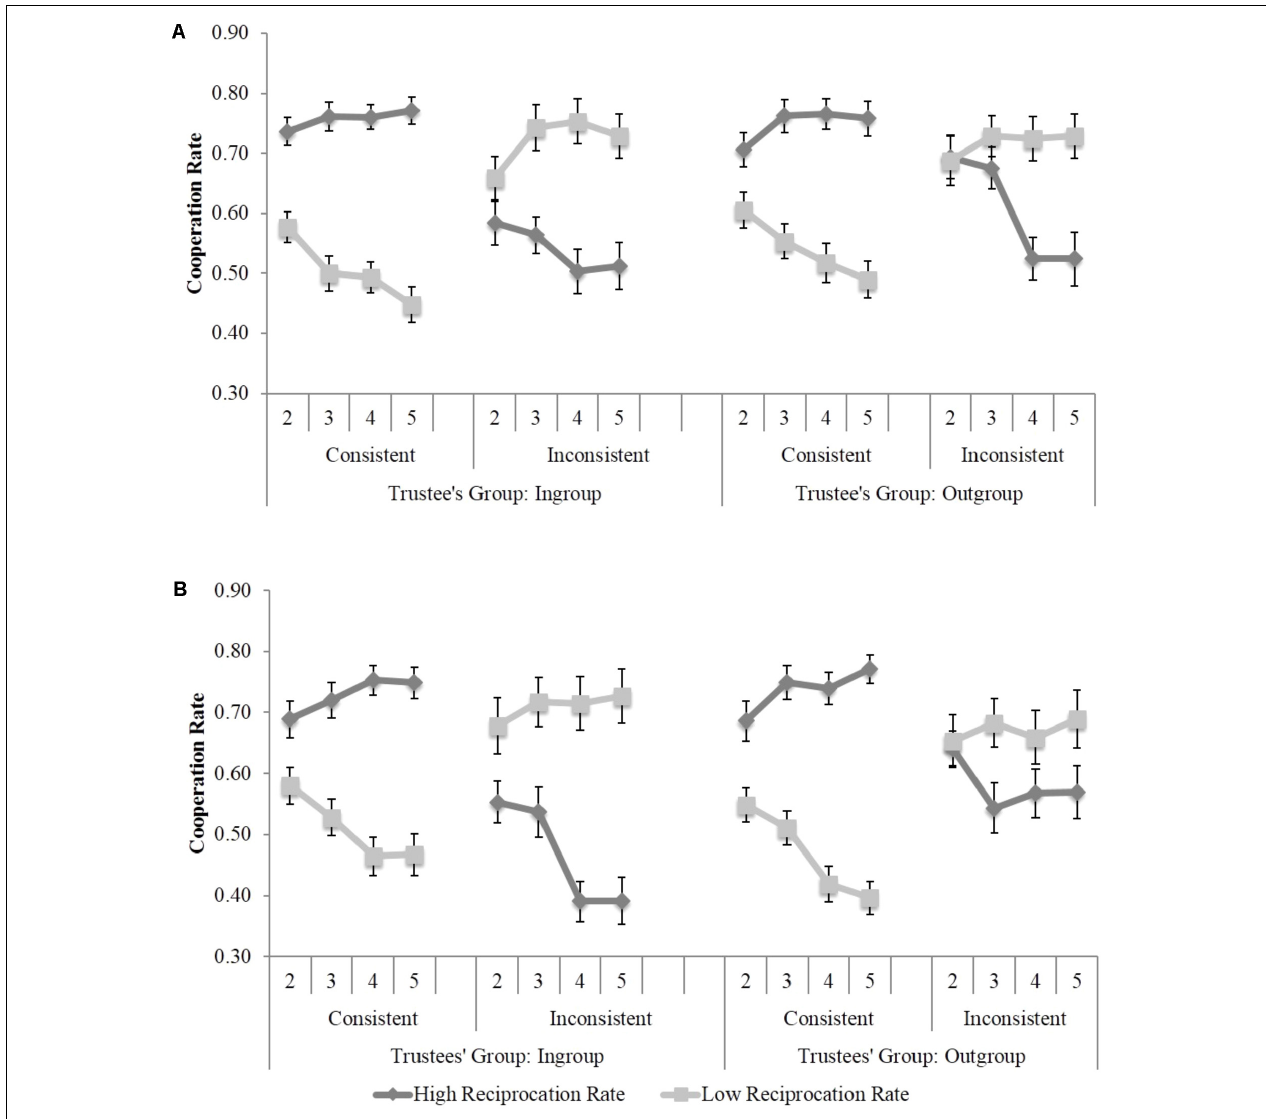
FIGURE 2 | Participants’ cooperation rates in Study 1 as a function of trustees’ group, individual consistency and blocks of trials. In this figure and the following ones, Blocks 2–5 referred to the learning blocks in both phases of the experiment and error bars represent the standard error of the mean retrieving the within-participants variability as in Cousineau (2005). (A) Study 1a: Gender. (B) Study 1b: